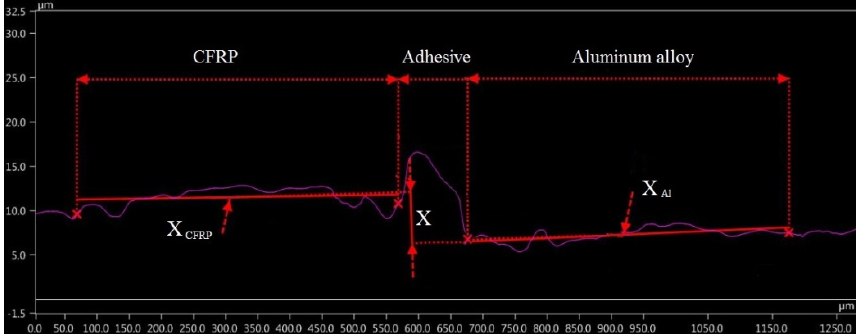
Figure 7. Method of determining the value of defect.